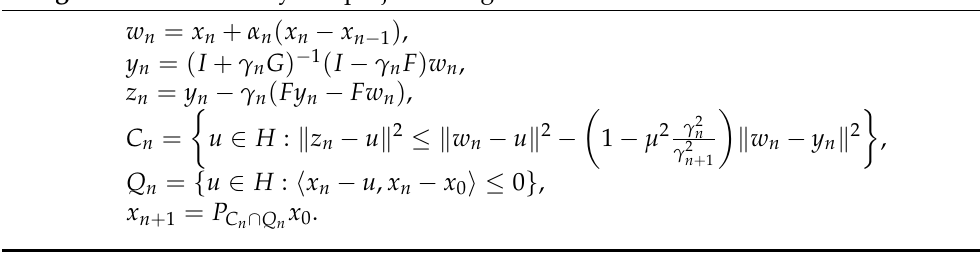
Algorithm 3: Inertial hybrid projection algorithm.